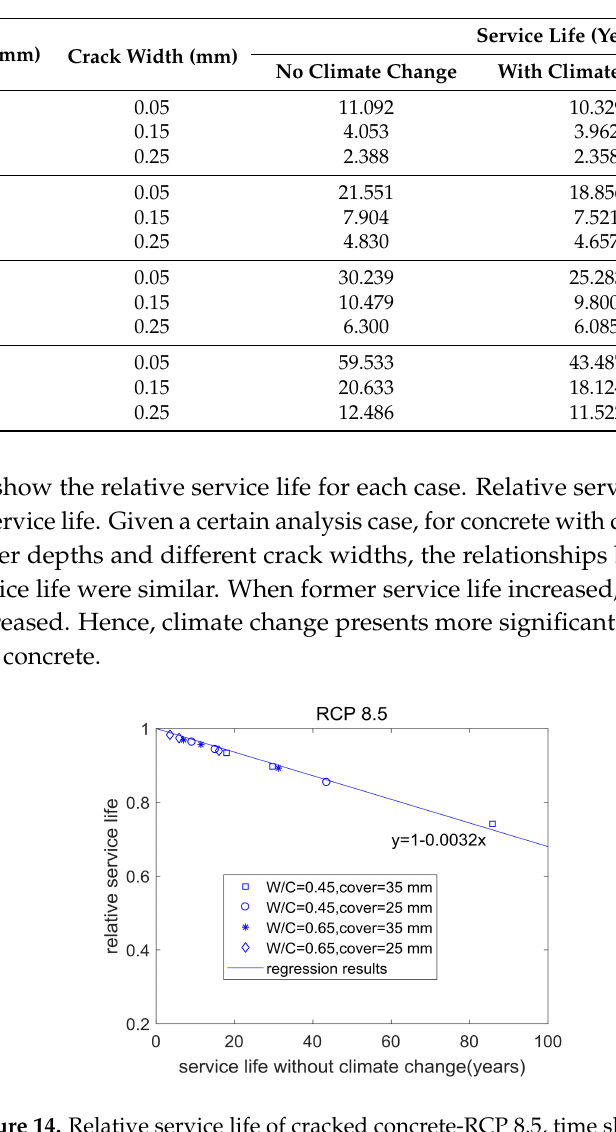
Figure 14. Relative service life of cracked concrete-RCP 8.5, time slice 2000.